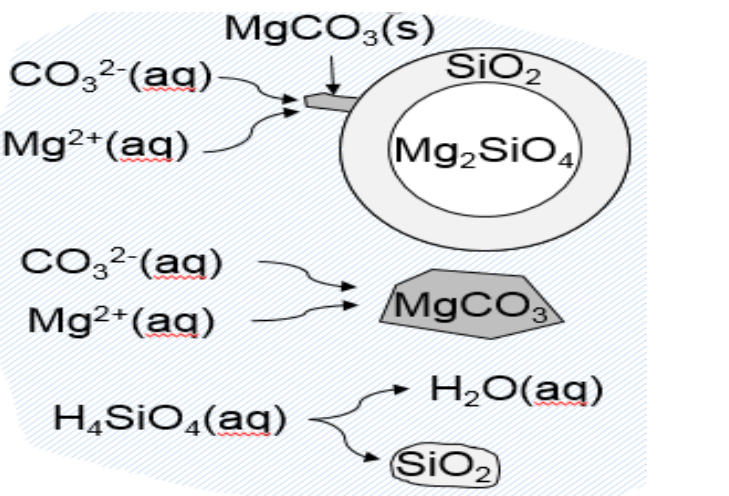
Figure 5 – The formation of the silica passivating